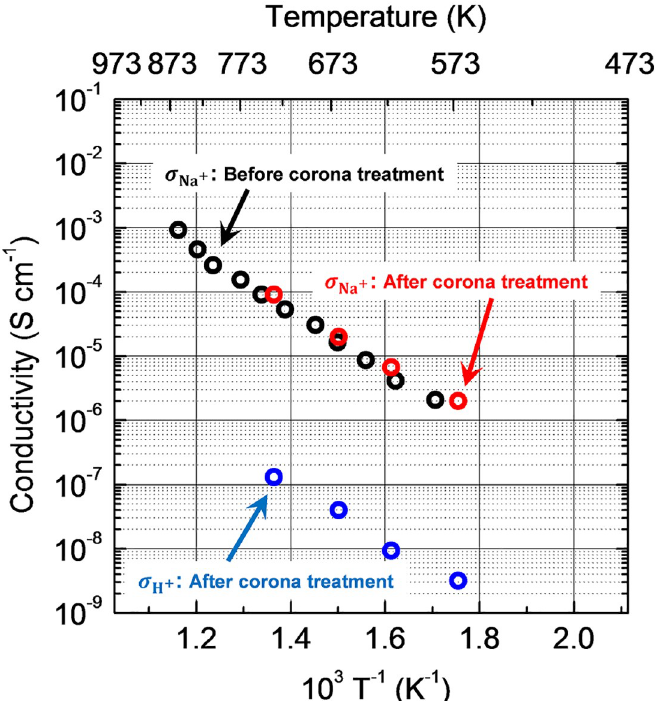
Fig 5. Ion conductivities of sodium ions and protons in the SLS glass before and after CDT. Ion conductivities are indicated as σ . No proton conduction was visible before the CDT.